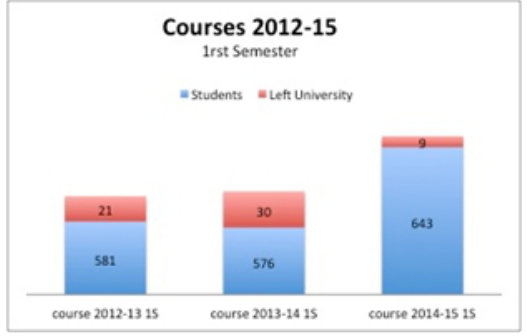
Figure 4. Number of students that left